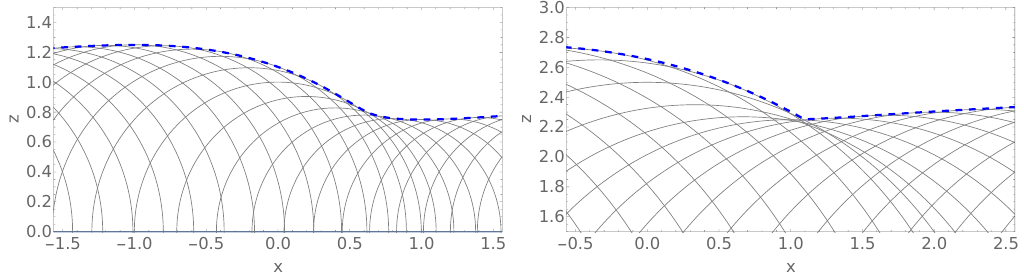
Figure 7 . Construction of the enveloping function z t t 1 = 1 (left) and t 1 = 2 : 5 (right). We see that z 1 ( x ) (left) is a smooth function while z 2 : 5 ( x ) (right) has developed a kink. This indicates the presence of a caustic point on the lightfront somewhere between t 1 = 1 and t 1 = 2 :